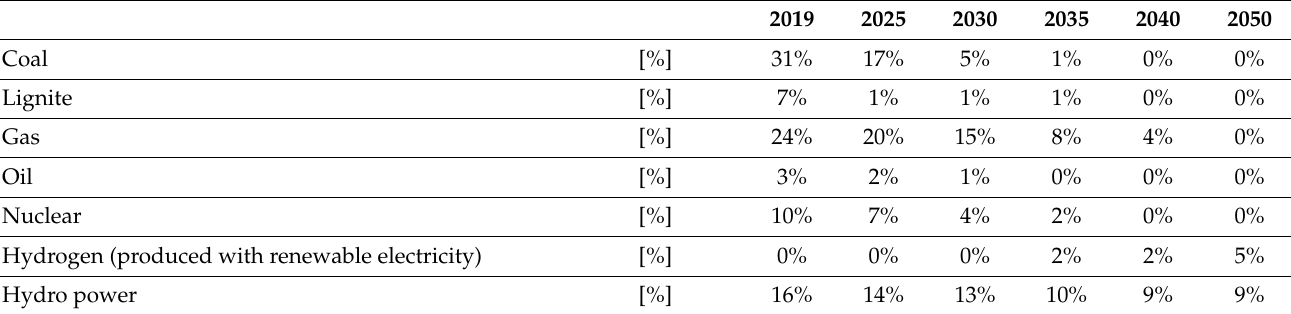
Table 20. Global electricity supply shares under the OECM 1.5 ◦ C